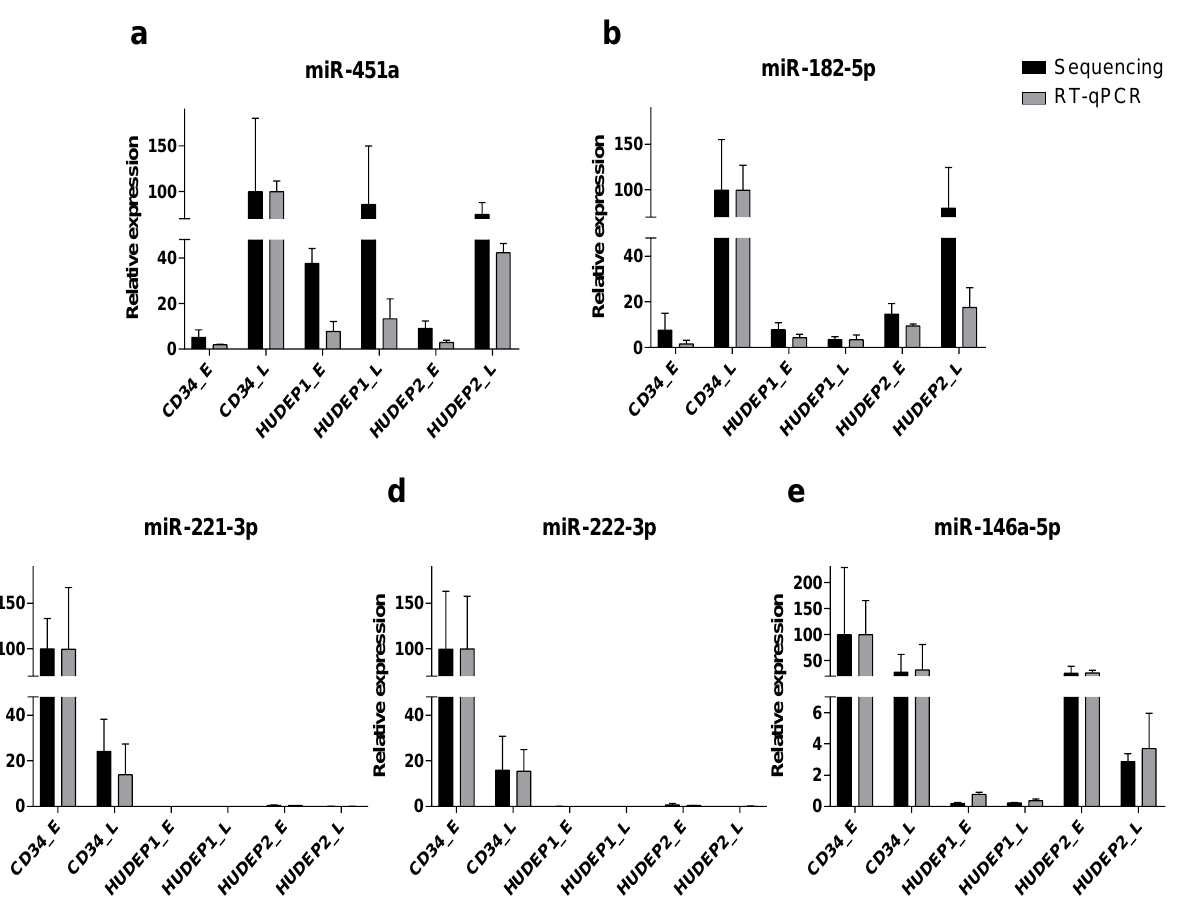
Figure 8. Validation of sequencing data with RT-qPCR analysis of selected miRNAs. ( a – e ) The expression of five miRNAs (miRNA-451a, miRNA-182-5p, miR-221-3p, miR-222-3p, and 146a-5p) was analyzed by RT-qPCR and normalized using miRNA-93-5p as an endogenous control for RNA input. All RT-qPCR experiments were carried out in triplicates. The miRNA expression is presented as mean ± standard deviation (SD), normalized to the highest sample